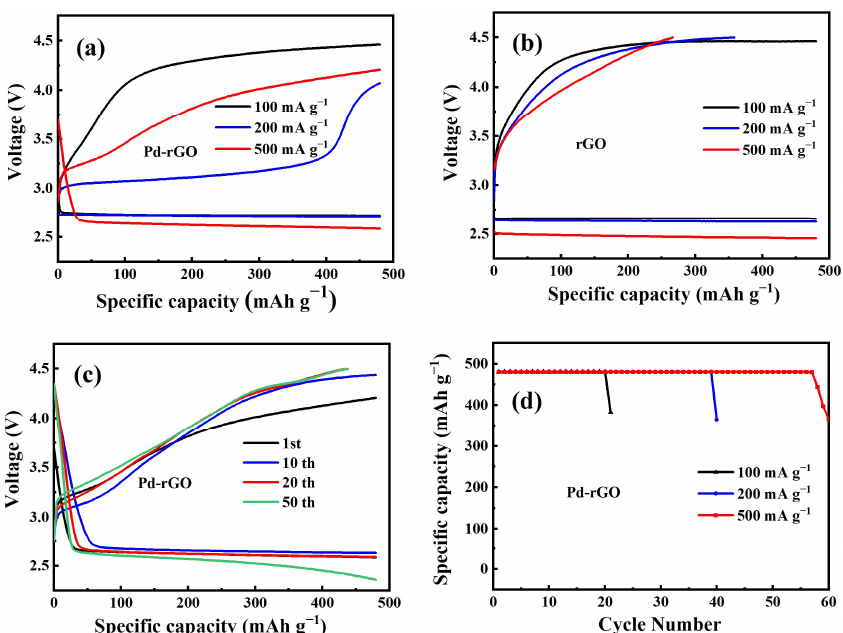
current densities of 100, 200, and 500 mA g −1 , the closed Li-O 2 battery can be cycled to 20, 39, and 57 cycles, respectively.